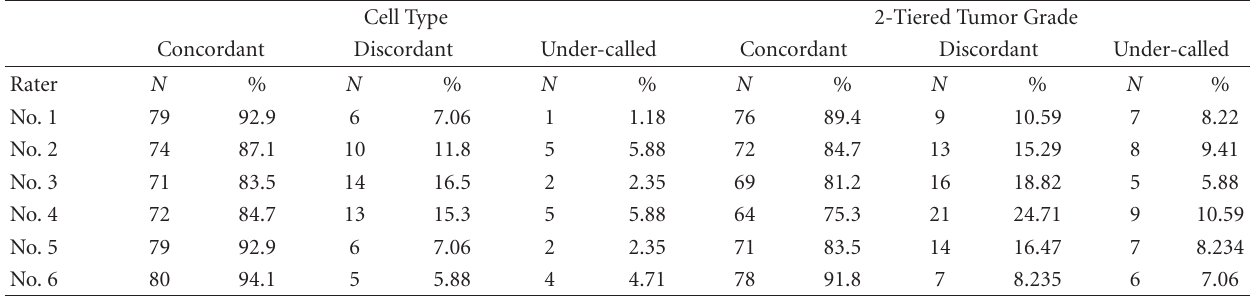
Table 2: Concordance between interpretation of endometrial biopsies by rater and paired resection specimens (available in 85 patients). Cell Type 2-Tiered Tumor